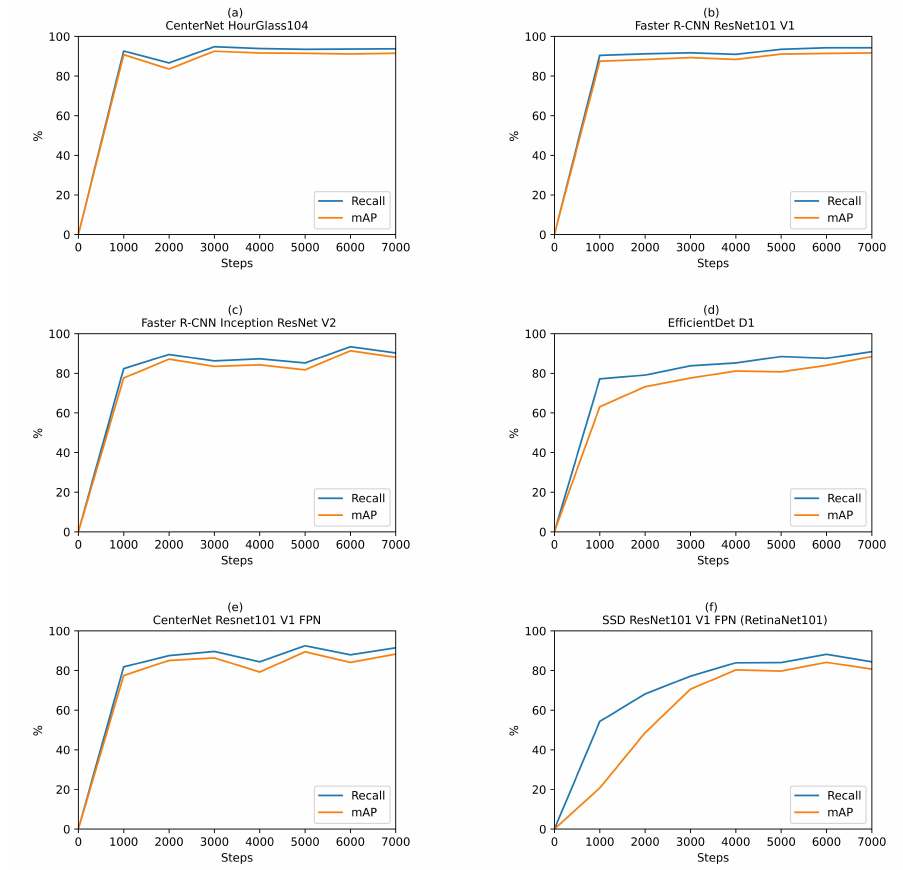
Figure A2. Recall and mAP evaluation graphs of the trained CNN